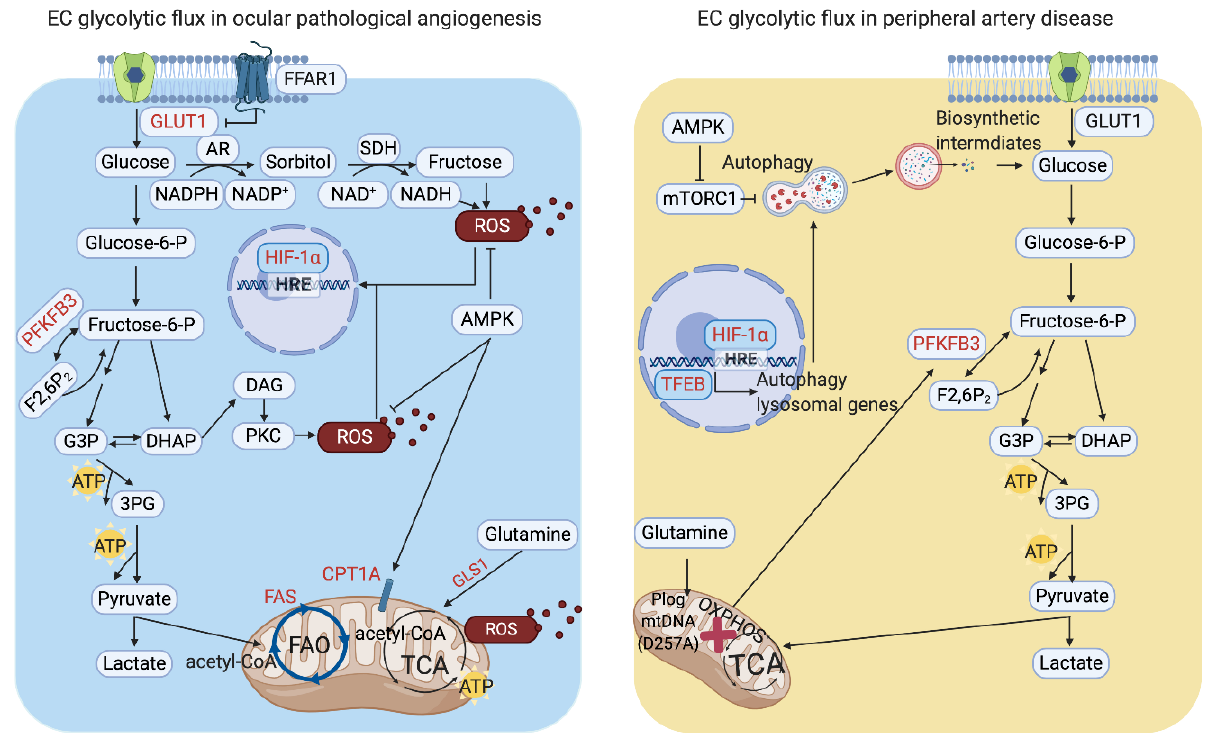
Figure 2. Endothelial cell (EC) glycolytic flux in ocular angiogenesis and peripheral artery disease (PAD). Retinal ECs utilize both glycolysis and fatty acid oxidation (FAO) for adenosine triphosphate (ATP) production. High glucose level leads to overproduction of mitochondrial reactive oxygen species (ROS) in ECs. The accumulated glycolytic intermediates result in lower glycolytic flux, which further increases ROS in both mitochondria and cytosol in diabetic ECs. ECs in PAD show impaired oxidative phosphorylation. Under energy deficiency conditions, phosphofructo-2-kinase/fructose-2,6- biphosphatase 3 (PFKFB3), glycolytic flux, and autophagy have protective effects on ECs in PAD. Red color represents the metabolic genes that positively regulate angiogenesis. GLUT1, glucose transporter 1; AR, aldose reductase; SDH, Sorbitol dehydrogenase; NADPH, nicotinamide adenine dinucleotide phosphate; NADH, nicotinamide adenine dinucleotide; AMPK, AMP-activated protein kinase; G3P, glyceraldehyde 3-phosphate; DHAP, dihydroxyacetone phosphate; DAG, diacylglycerol; PKC, protein kinase C; 3PG, 3-phosphoglyceric acid; FAS, fatty acid synthase; CPT1A, carnitine palmitoyltransferase 1A; GLS1, glutaminase 1; mTORC1, mammalian target of rapamycin complex 1; OXPHOS, oxidative phosphorylation; acetyl-CoA, acetyl coenzyme A; TCA, tricarboxylic acid cycle; F2,6P 2 , fructose 2,6-bisphosphate; TFEB, transcription factor EB; HIF-1 α , hypoxia-inducible factor 1-alpha; HRE, hypoxia response elements; Plog, mitochondrial DNA polymerase gamma; mtDNA, mitochondrial DNA.